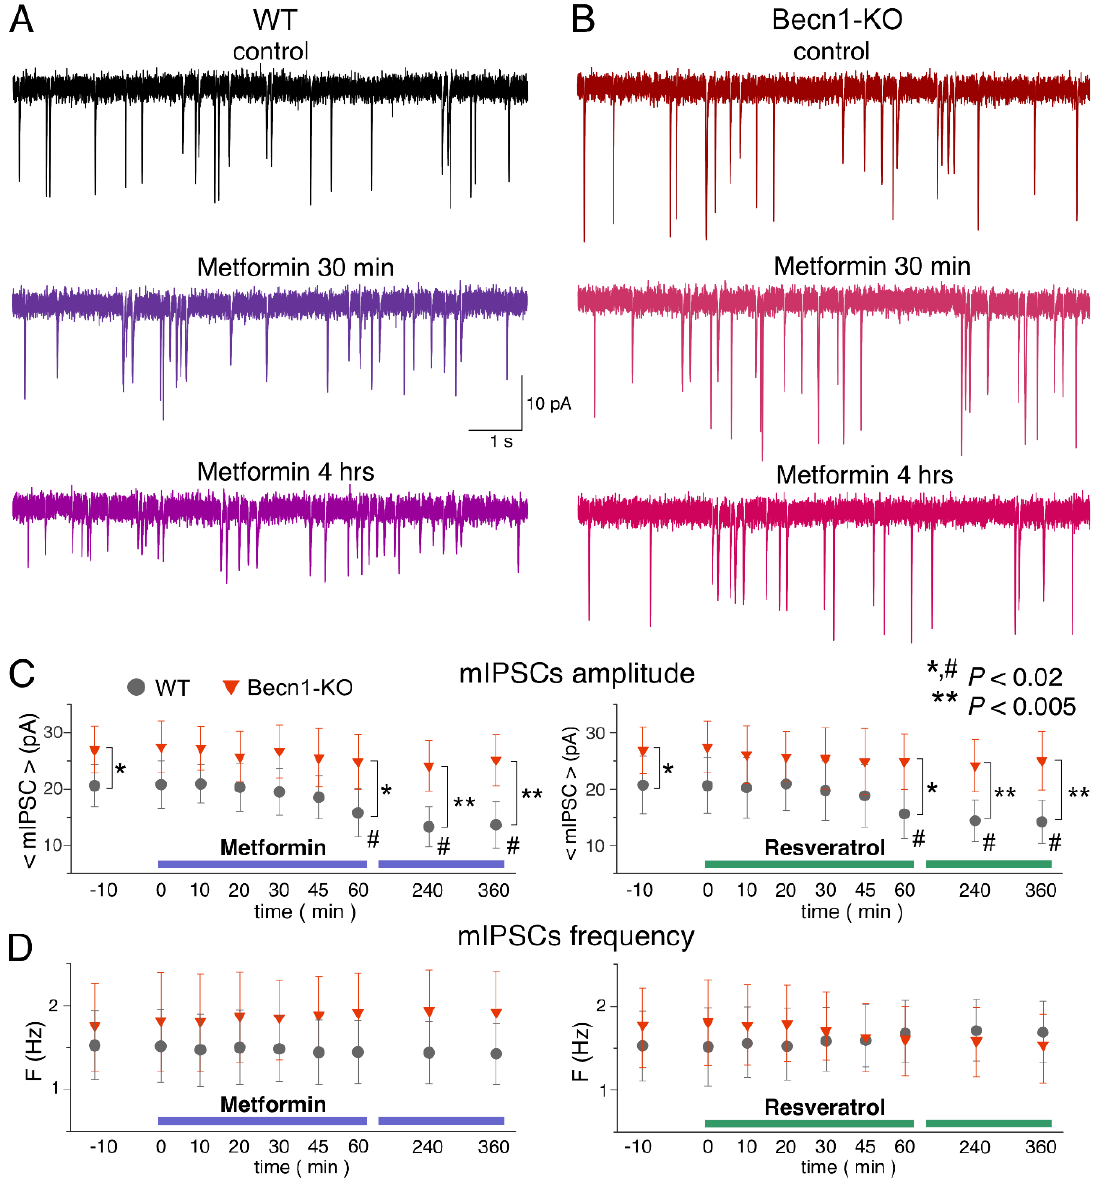
Figure 5. Effects of autophagy modulators on inhibitory synaptic transmission in the neocortical neurons. The GABAergic mIPSCs were recorded as in the Figure 3. ( A , B ) The representative mIPSCs recorded in the neurons of the Becn1 +/+ ( A ) and Becn1 +/− ( B ) mice in the control (top row) and after application of metformin (5 µM) for 30 min (middle row, the same neuron as in the control) and 4 h (bottom row); the scale is the same in all panels. Note the significant decrease in the mIPSC amplitude in the WT neuron after 4 h-long application of metformin. ( C , D ) Each dot shows the average amplitude and frequency of spontaneous currents recorded in a 2 min time window in the pyramidal neurons of wild-type and Beclin1-deficient mice during application of metformin (5 µ M) and resveratrol (20 µ M). The drugs were applied at the zero time point; data are presented as means ± SDs for nine neurons. The asterisks (* or **) indicate the statistical significance of the differences between the Becn1 +/+ and Becn1 +/ − mice. The hash symbols (#) indicate the statistical significance of the effects of drugs as compared to the neuron of the same genotype in the control. A decrease in the amplitude of mIPSCs was observed in the wild-type but not in the Beclin1-deficient